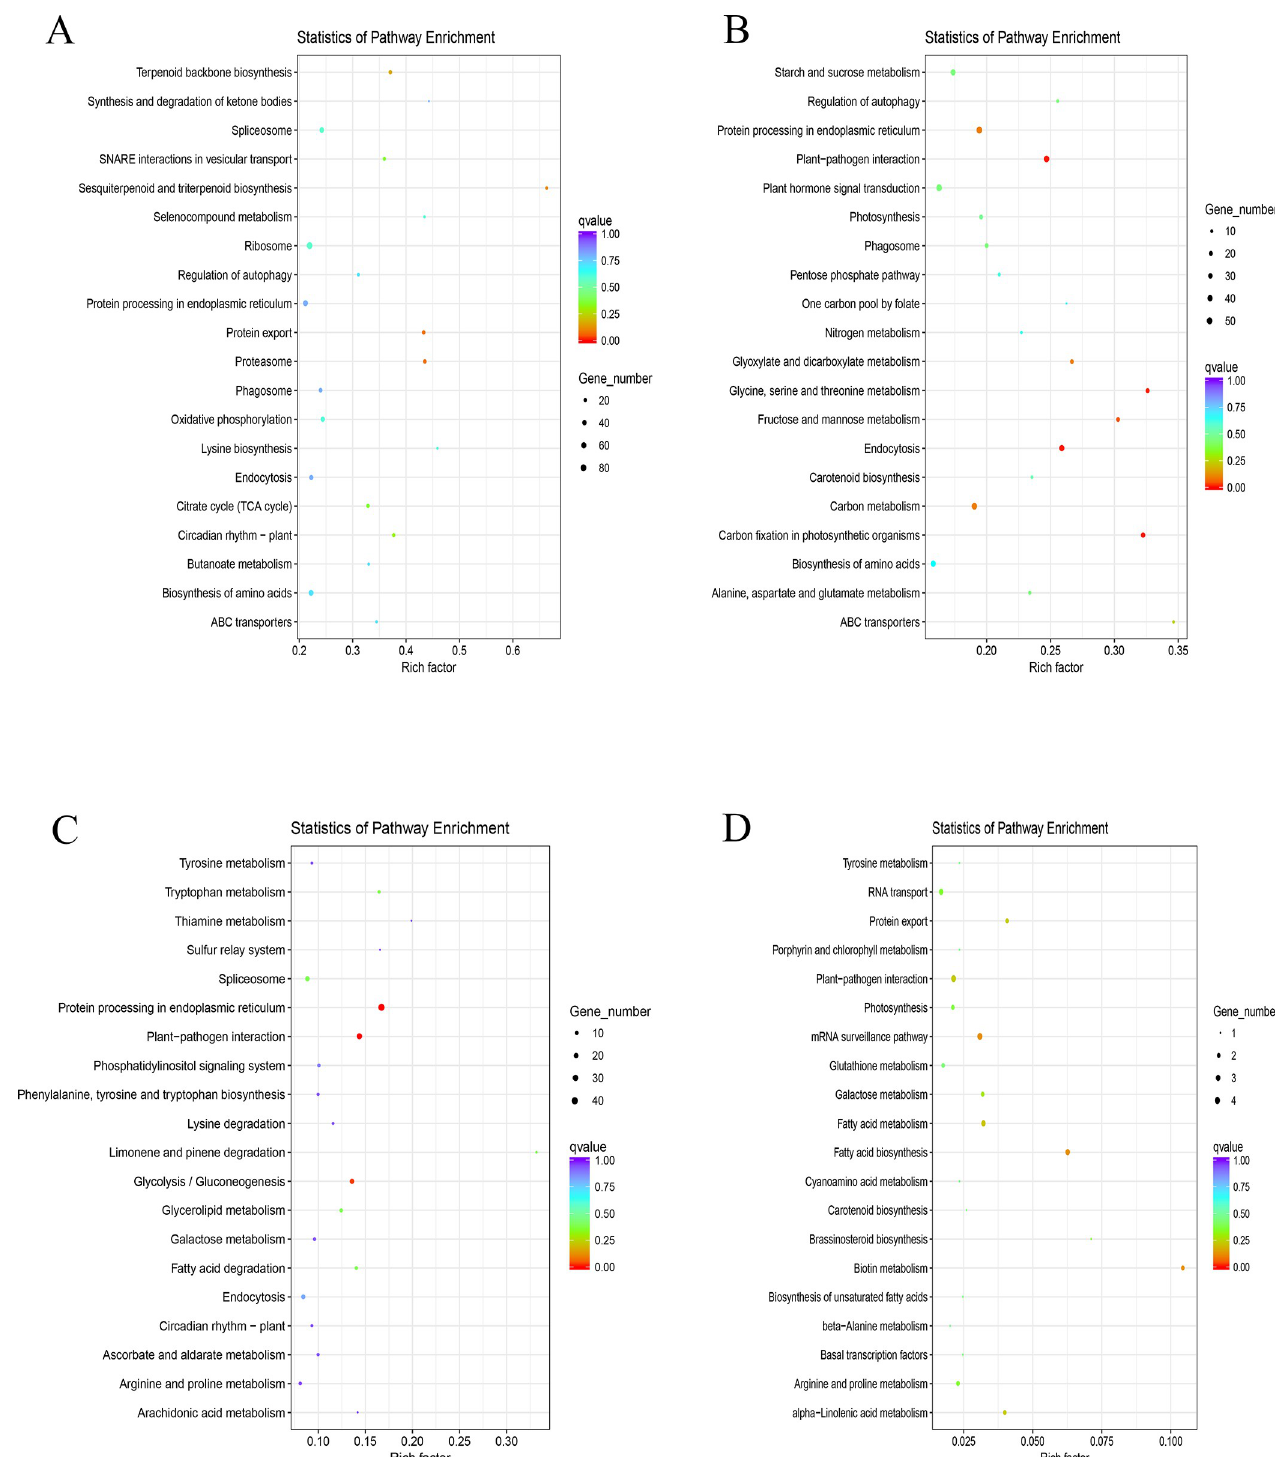
Fig 5. Genes in modules were analyzed by KEGG pathway. (A-D) represent MEblue, MEgreenyellow MEyellow, MEblack, and MEsalmon modules, respectively. the ordinate represents KEGG pathways and the abscissa represents Rich factor. Rich factor is the ratio of differentially expressed genes (DEGs) enriched in this pathway to the total number of annotated genes in the pathway. The size of the points indicates the number of DEGs in each pathway and the colors of the dots represent different p-values; the closer you get to red, the more significant the enrichment.